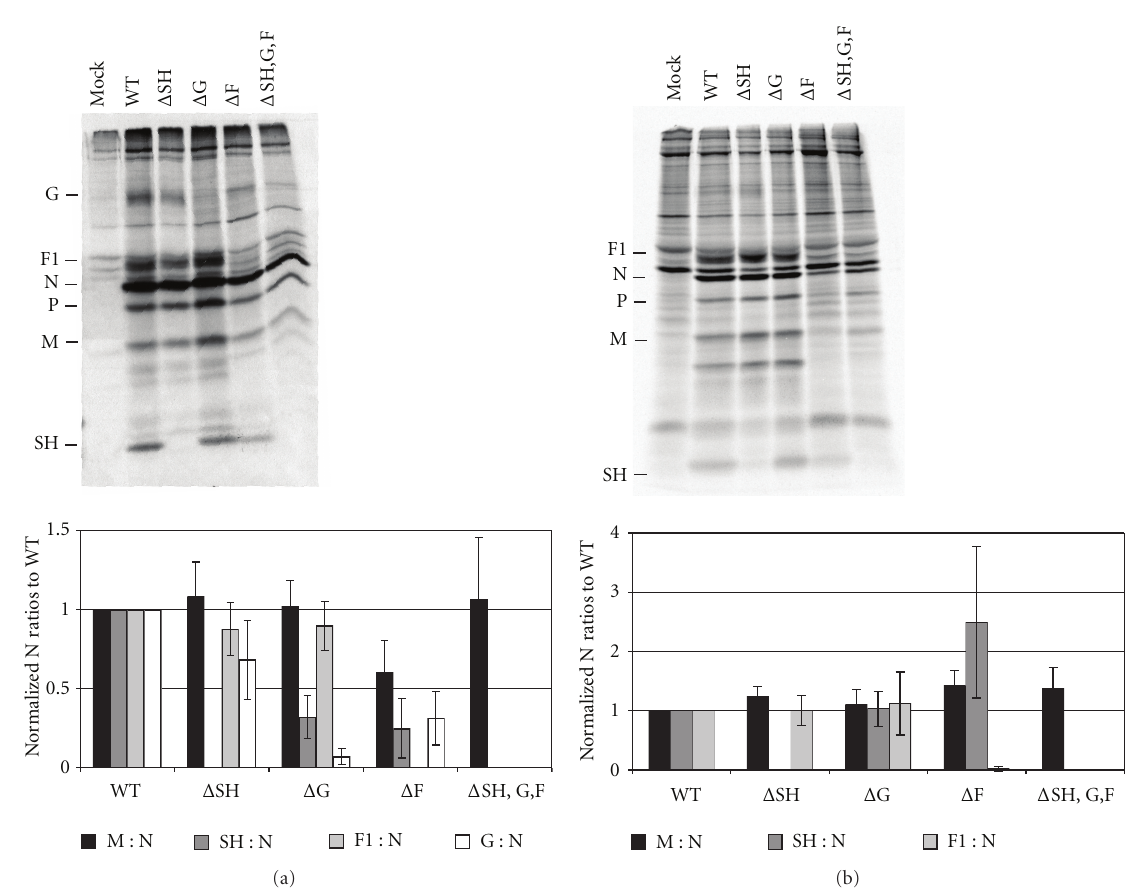
Figure 4: E ff ect of deletion of glycoprotein genes on the incorporation of HRSV proteins into released viral particles. Twenty-four hours after infection, A549 cells infected with WT or glycoprotein deleted HRSV at a MOI of 1.0 were radiolabeled with 35 S Cys/Met for 16 h. The supernatant containing the released viral particles was collected, cleared of cell debris, and concentrated by centrifugation. (a) The viral pellet was resuspended, and viral proteins were immunoprecipitated with a polyclonal anti-HRSV antibody along with monoclonal antibodies against G and SH. Proteins were analyzed by electrophoresis on a 12% SDS polyacrylamide gel. A representative gel is shown. The bar graph depicts ratios of each HRSV structural protein to N protein, normalized to the ratios found in WT viral particles. (b) Infected cells were lysed and viral proteins were immunoprecipitated with a polyclonal anti-HRSV antibody along with antibodies against G and SH. Proteins were analyzed on a 12% SDS-PAGE. A representative gel is shown. The bar graph depicts ratios of each HRSV structural protein to N protein, normalized to the ratios found in WT-infected lysate. Proteins were quantitated on a phosphorImager. Error bars represent standard deviation from at least three